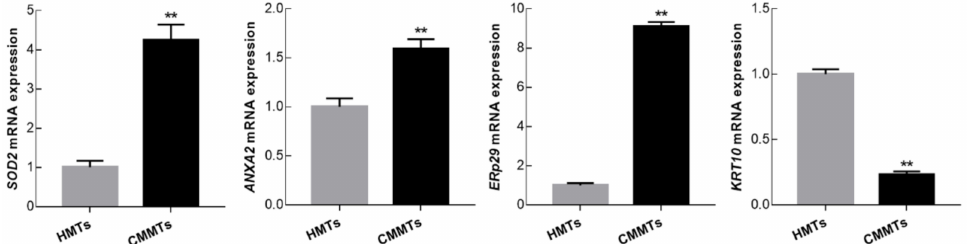
Figure 6. Relative mRNA expressions for selected randomly four di ff erentially expressed proteins (DEPs) were detected by qRT-PCR. Data show means ± SD (n = 3). ** p < 0.01. HMTs, healthy mammary tissues. CMMTs, mammary tissues with clinical